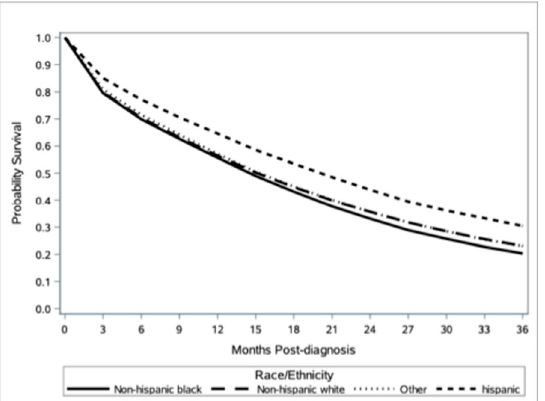
Fig 2. 3-Year overall unadjusted patient survival curves by race using the life-table